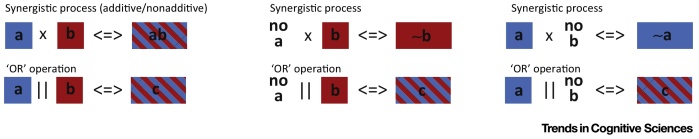
Illustration of How Different Multisensory Neural Mechanisms Could be Dissociated by Eliminating One Form of Sensory Input (a or b).